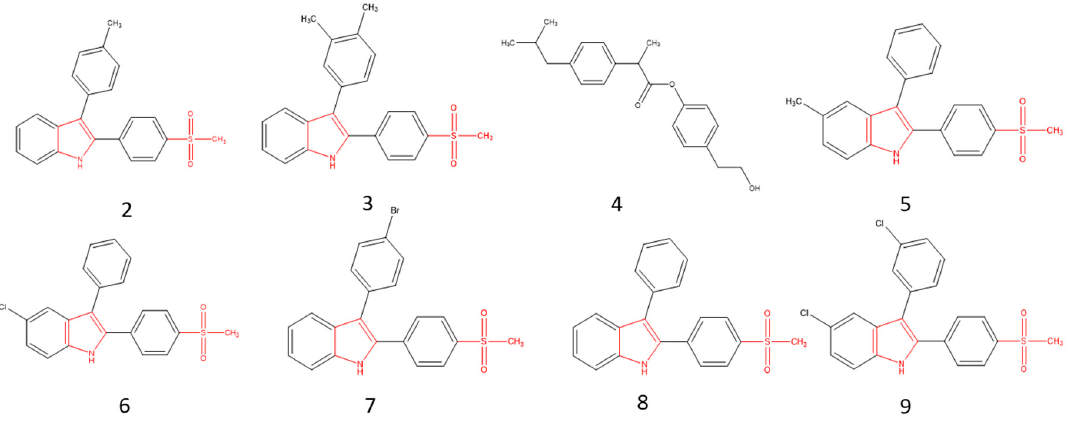
Figure 3. The most active molecules.